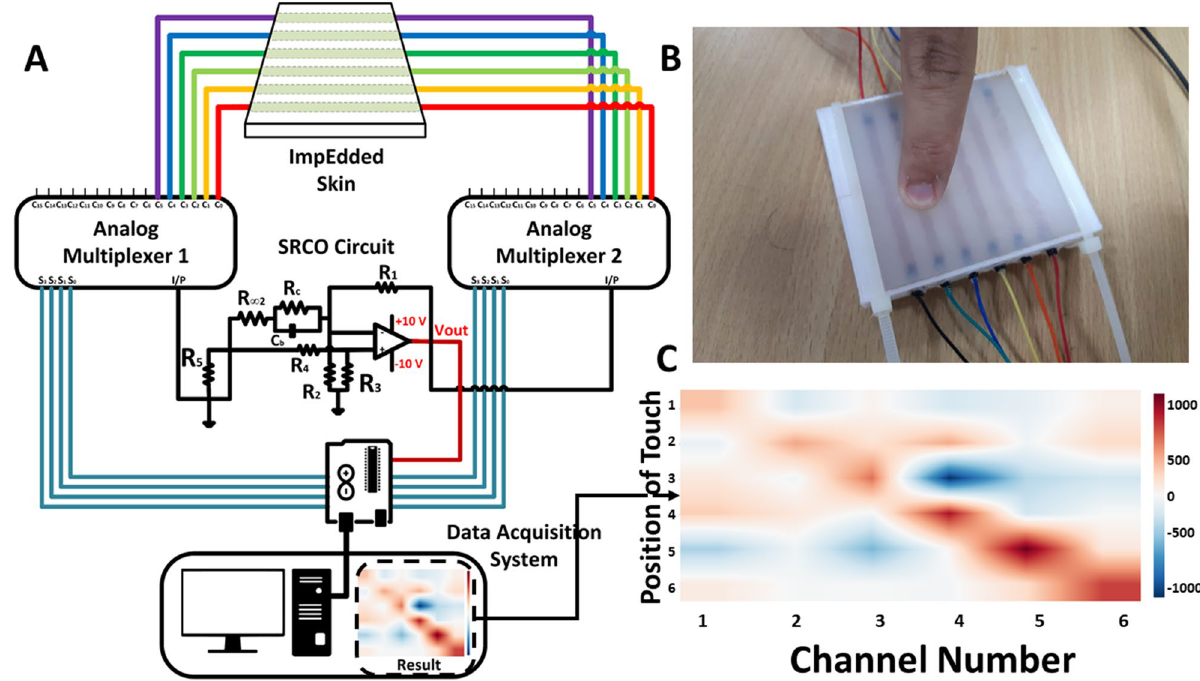
Figure 7. The ImpEdded skin experiment. ( A ) A special circuit is designed to acquire the frequency output from the SRCO circuit for each channel. Using two analog multiplexers and a microcontroller development board (Arduino UNO), switching between the six channels was possible. Then the frequency output for all the channels at each pressing iteration is readable. The data is acquired on a pc and the variation of frequencies before and after pressing is computed and represented on a heat map. ( B ) ImpEdded skin has six channels filled with Aloe Vera-gelatin mixture under pressing. ( C ) Each of the horizontal row represents an iteration of pressing on each channel, starting by the first channel at the first row and ending by the sixth channel at the bottom row, while each column represents the channels from left to right. The measurements on each tile represents the difference in frequency before and after pressing